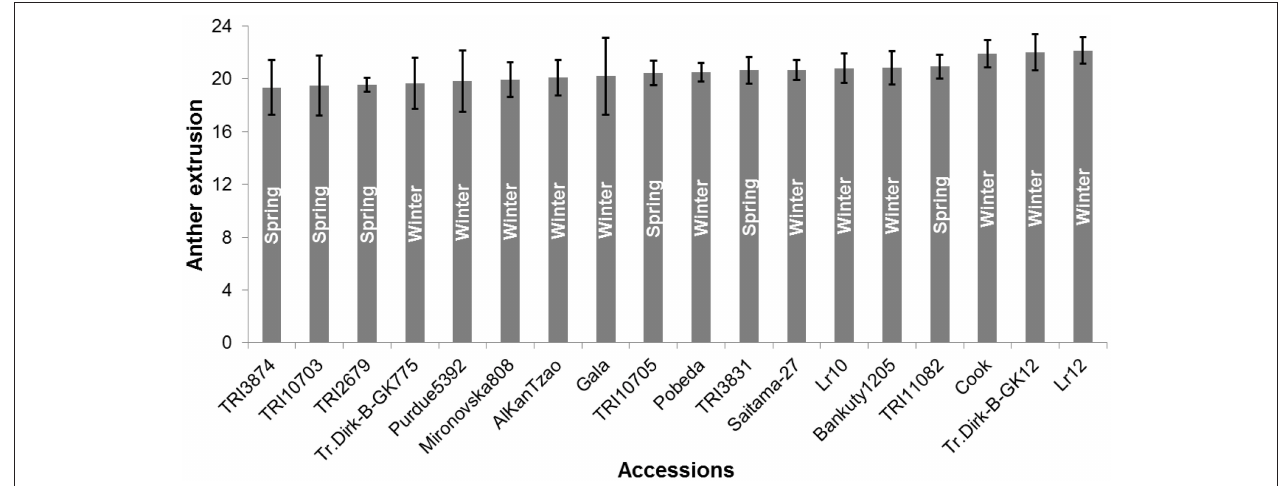
FIGURE 2 | Anther extrusion (AE) performance of the top anther extruding accessions based on Best Linear Unbiased Estimates (BLUEs) ± SE. Six spring and 12 winter wheat accessions showed AE > 80%. The growth habit of the accessions is indicated within the bars. Numbers on the Y-axis represent the number of extruded anthers.